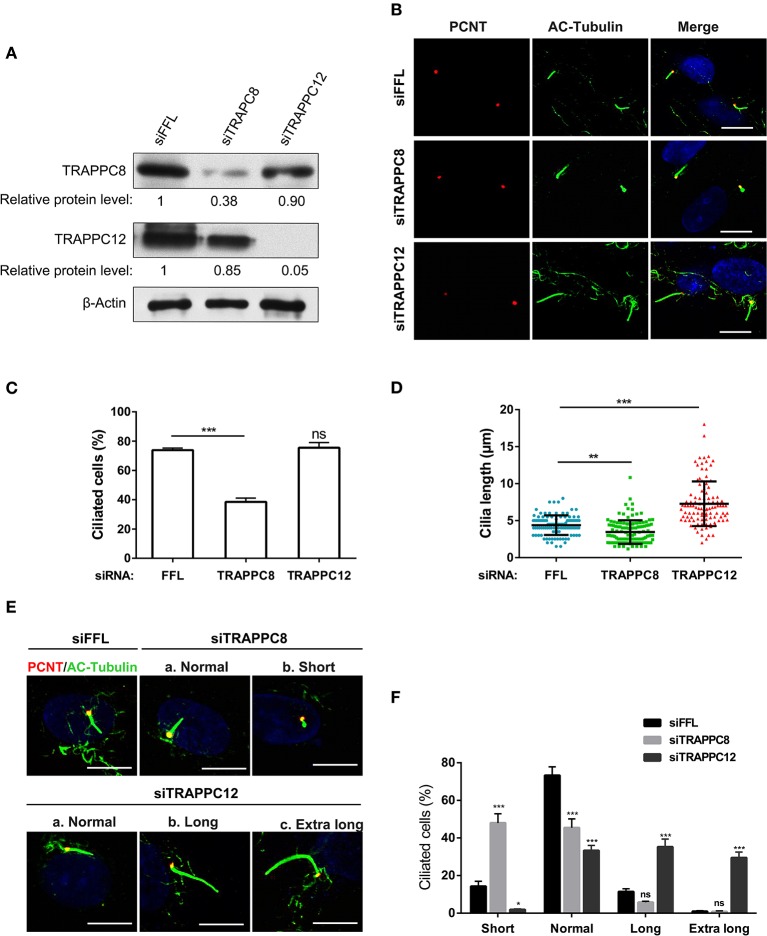
TRAPPC8 and TRAPPC12 depletions change ciliary length. (A) hTERT-RPE1 cells were transfected with control (siFFL), TRAPPC8 siRNA (siTRAPPC8) or TRAPPC12 siRNA (siTRAPPC12) for 72 h. FFL siRNA targets the firefly luciferase gene sequence, which is not present in human genome, and therefore, serves as non-targeting siRNA control. The expression level of the indicated proteins was analyzed from whole cell lysates by immunoblotting using antibodies against TRAPPC8, and TRAPPC12. β-Actin served as a loading control. (B) hTERT-RPE1 cells depleted TRAPPC8 or TRAPPC12 were induced with primary cilum formation. The approximate positions of the centrosome were indicated by PCNT (pericentrin) staining and primary cilia were indicated by AC-tubulin. (C,D) Percentage of cells with primary cilia and quantification of ciliary length in ciliated cells. Cilium length was measure by imageJ software and based on the scale bar length at 10 μm to set measurement scale. siFFL, n = 105; siTRAPPC8, n = 121; siTRAPPC12, n = 105. Mean ± SEM, *p < 0.05;**p < 0.01; ***p < 0.001, no matching or pairing one-way ANOVA. (E) TRAPPC8 depletion caused short primary cilia, while TRAPPC12 depletion caused aberrantly long primary cilia. (F) Percentage of cells with short cilia (0–3 μm); with normal cilia (3–6 μm); with long cilia (6–8 μm); with extra long cilia (>8 μm). siFFL, n = 168; siTRAPPC8, n = 185; siTRAPPC12, n = 165. no matching or pairing one-way ANOVA. Similar results were observed in three independent experiments.